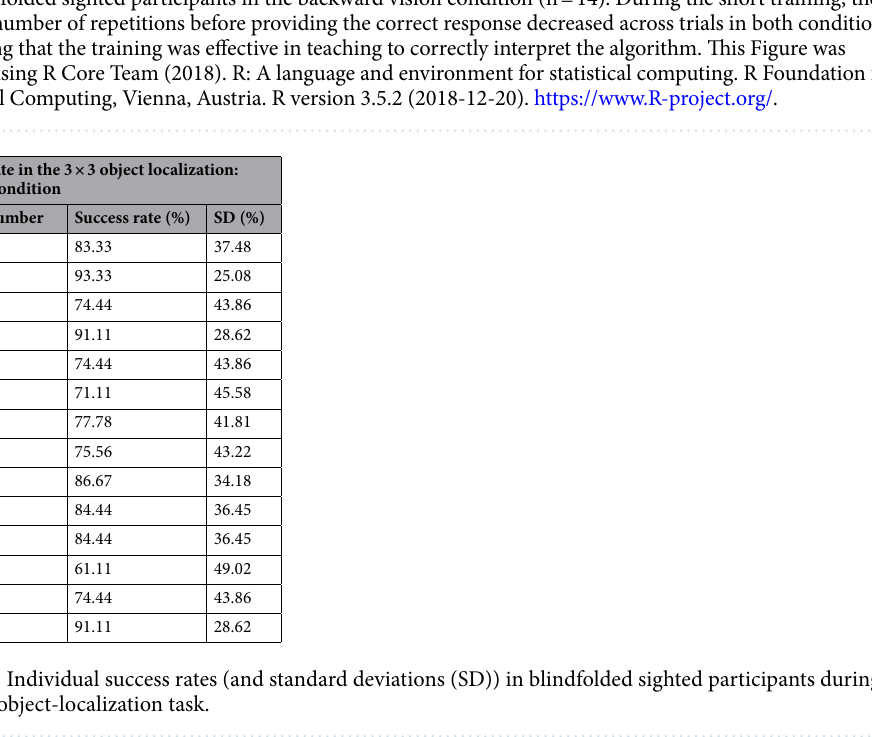
Table 1. Individual success rates (and standard deviations (SD)) in blindfolded sighted participants during the forward object-localization task.